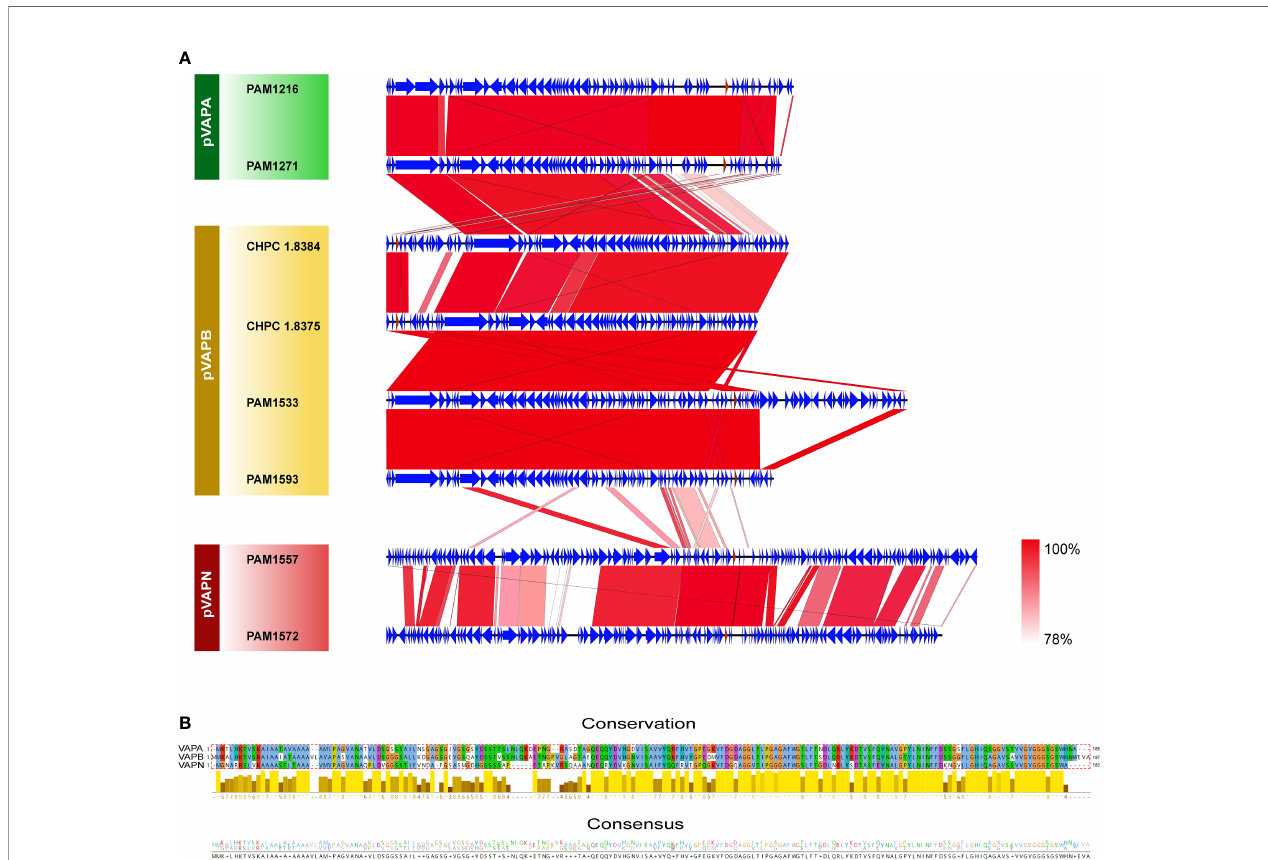
FIGURE 7 | Genome comparisons of the host-associated virulence plasmids of R.equi . (A) Collinearity analysis of three VAP plasmids. The CDSs were represented by arrows, and the red arrows represented vapA/B/N gene. Regions with similar sequences were connected and labeled from pink to red. (B) Sequence comparison of the three types of VAP proteins. The alignment, conservation and consistency of amino acid sequences of the three types of VAP proteins were shown from the top to the bottom. Conserved regions were represented by histogram, in which bright colors and long bars represented highly conserved, while dark colors and short bars represented less conserved. At the bottom, the number of amino acids at each position represented the degree of